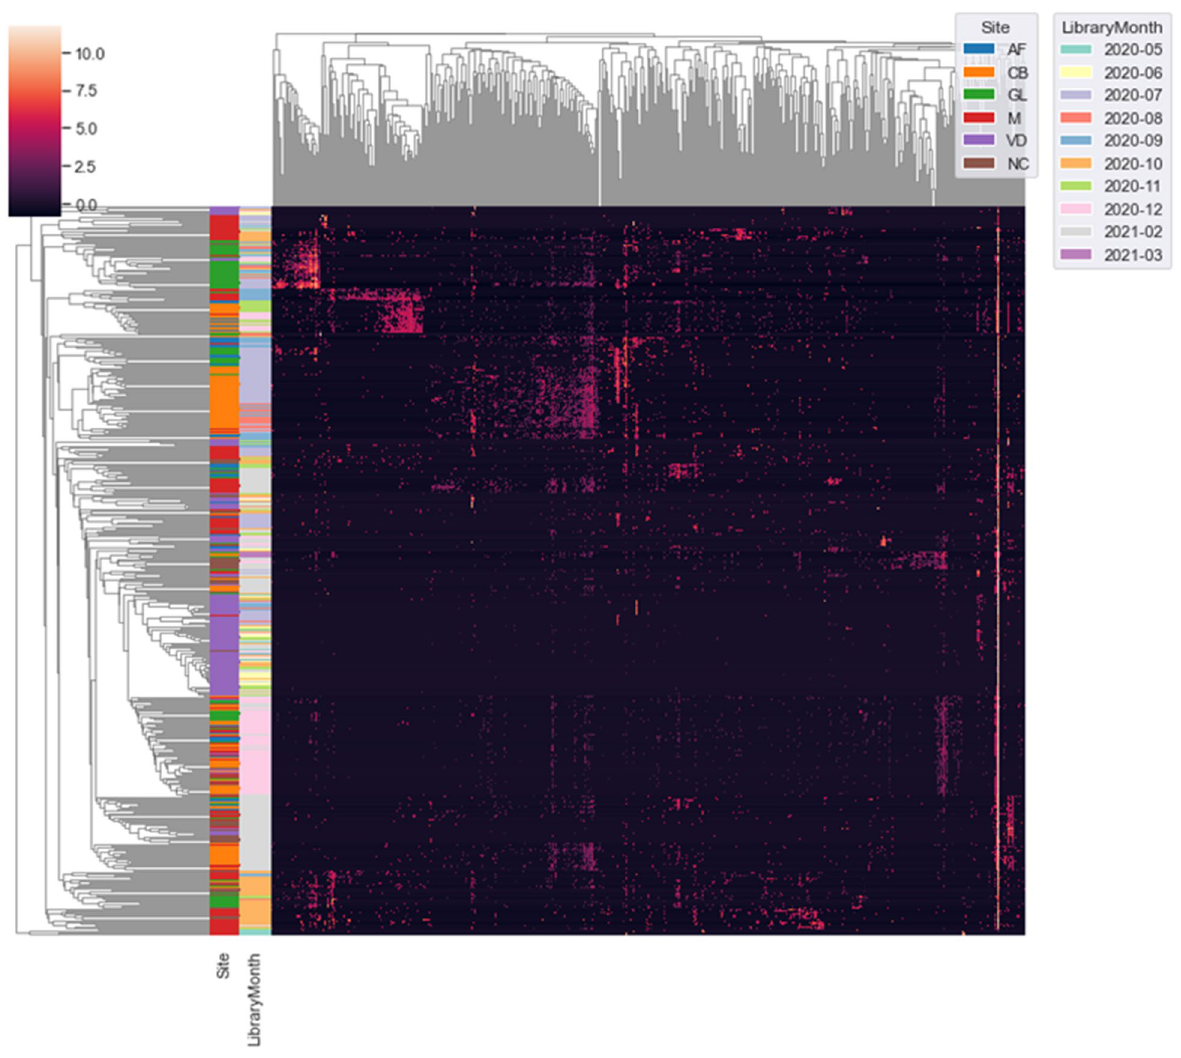
Figure 1. Batch effect detection in 16S rRNA amplicon sequencing data. Center log-ratio transformation was used to normalize the filtered ASV table before generating a hierarchically clustered heatmap based on correlation coefficients. AF, amniotic fluid; CB, umbilical cord blood; GL, gastric liquid; M, meconium; VD, cervicovaginal discharge; NC, negative